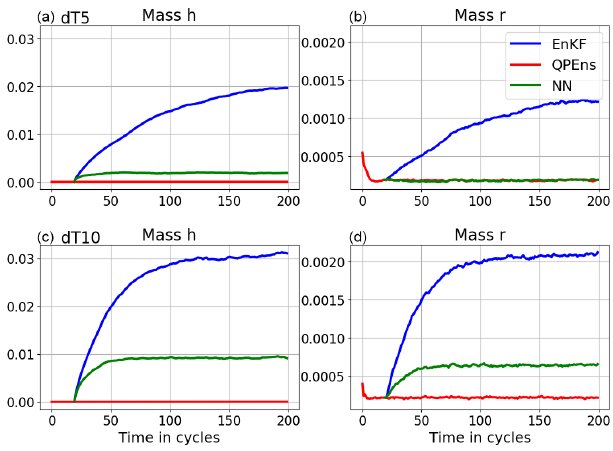
Figure 4. Absolute mass error averaged over 500 experiments of h (a, c) and r (b, d) for the analysis ensemble mean for the EnKF (blue), QPEns (red) and CNN (green). Panels (a) and (b) correspond to dT5 and panels (c) and (d) to dT10.